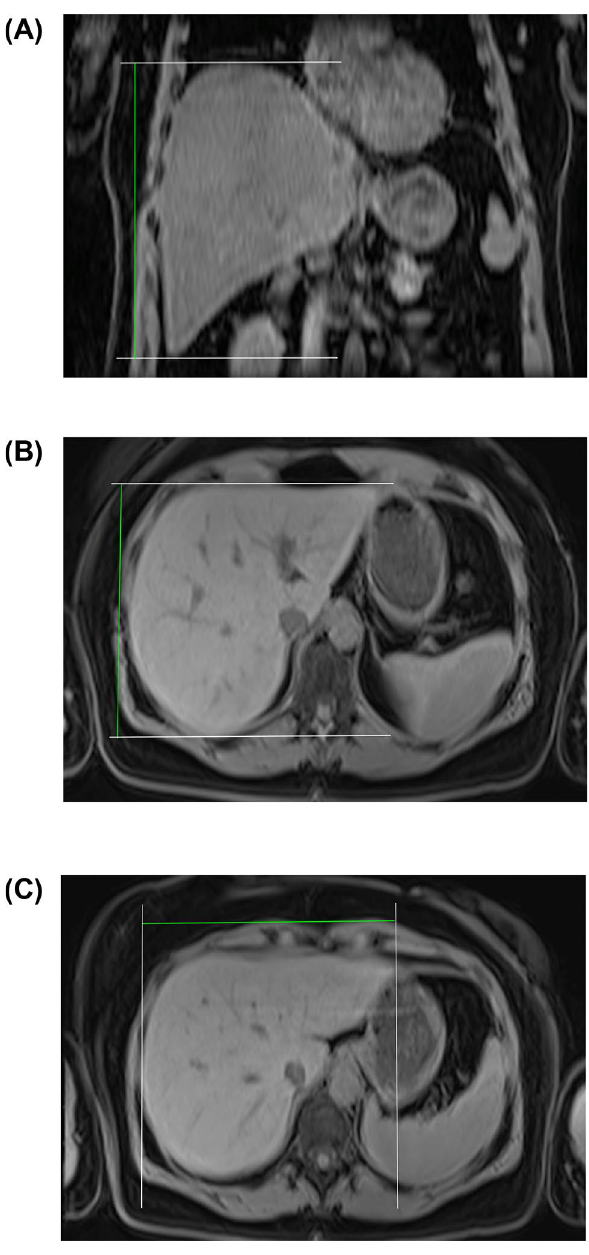
Figure 1. Sample measurement of diameters based on the MRI sectional images. Measurement of the maximum liver expansion in CC ( A ), AP ( B ) and ML ( C )